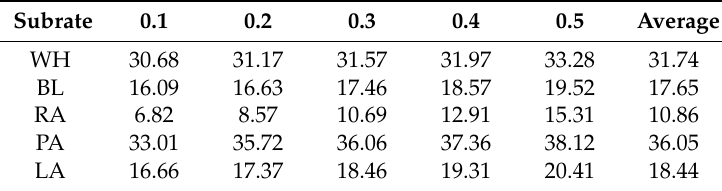
Table 2. Execution time (ms) of encoder for various measurement structures.